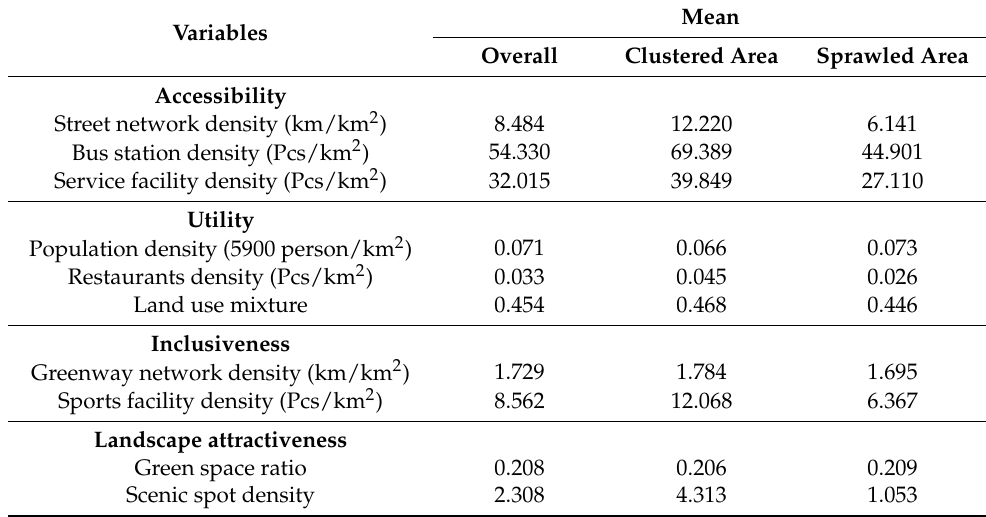
Figure 3. Spatial distribution of PA diversity. Table 7. Description of the characteristics of the residential built environment.